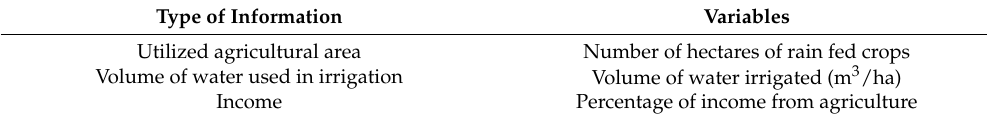
Table 7. Variables related to the level of risk based on the ANOVA, classified by the type of